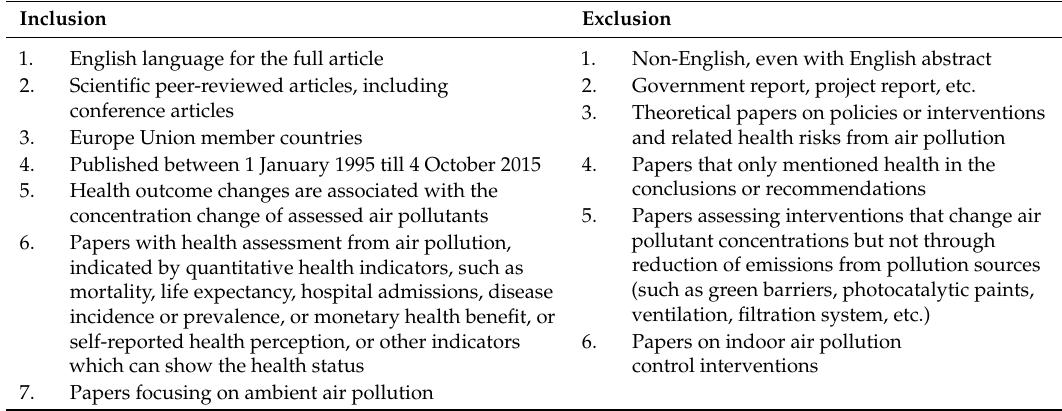
Table 1. Selection criteria for study inclusion and exclusion.